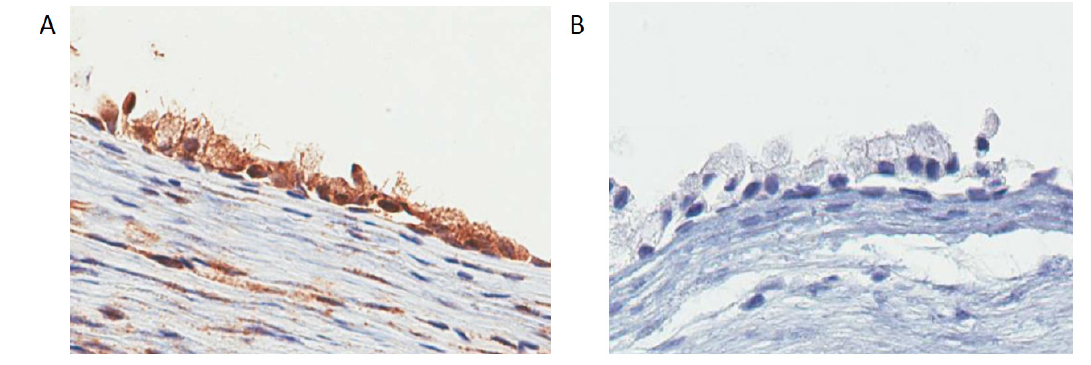
Figure 3. ( A ) Immunohistochemistry predominantly localises DMRT3 in airway epithelia of nasal polyps from AERD patients. ( B ) Negative control for DMRT3. A representative experiment of one of three nasal polyps.